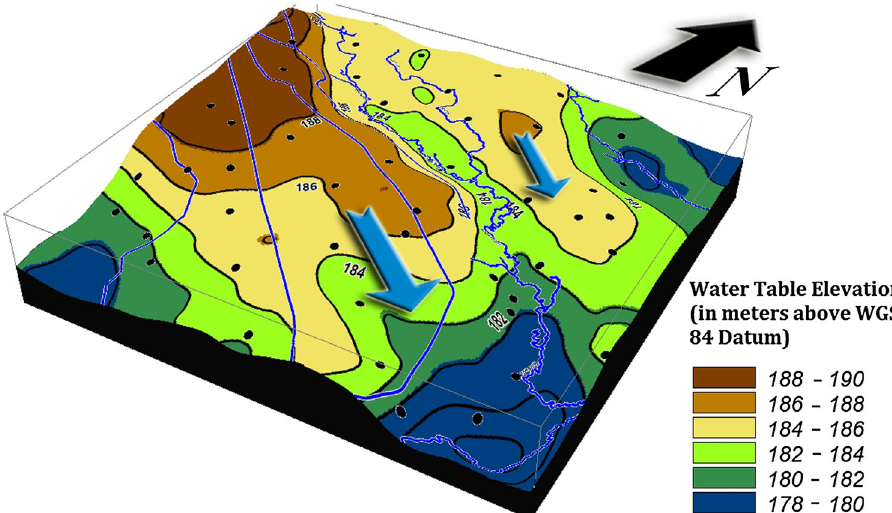
Fig. 3 Water table elevation map of the study area showing the regional groundwater flow direction in bold blue arrows (relief is vertically exaggerated to highlight groundwater